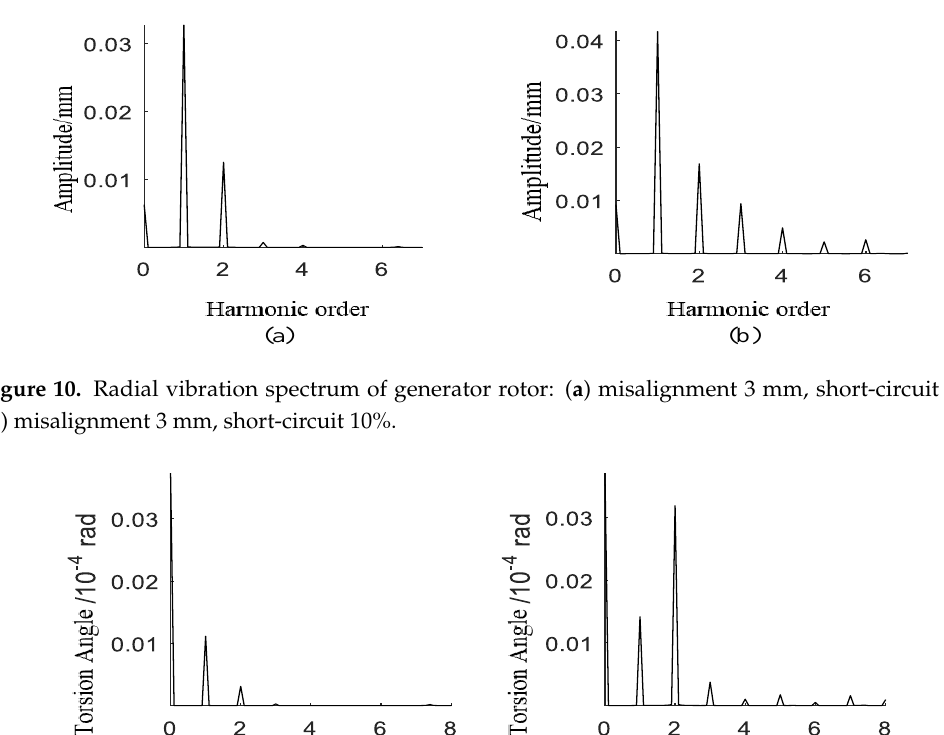
Figure 9. Vibration response axis locus of generator rotor: ( a ) misalignment 3 mm, short-circuit 1%; ( b ) misalignment 3 mm, short-circuit 10%.